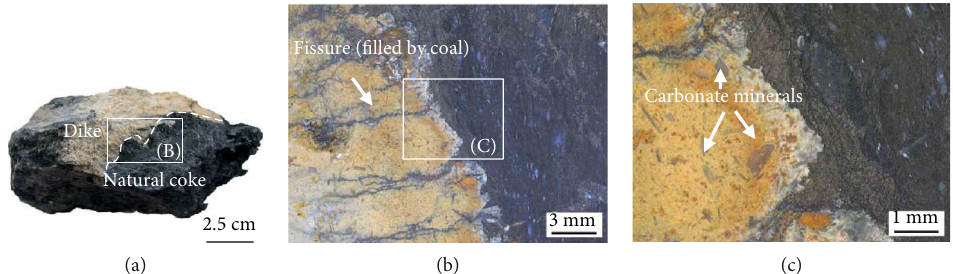
Figure 4: (a) Photo of sample TS6. (b) The coal lique fi ed and seeped into fi ssures at high temperature (stereomicroscopic images). (c) Carbonate minerals at the contact between the dike and natural coke (stereomicroscopic images).